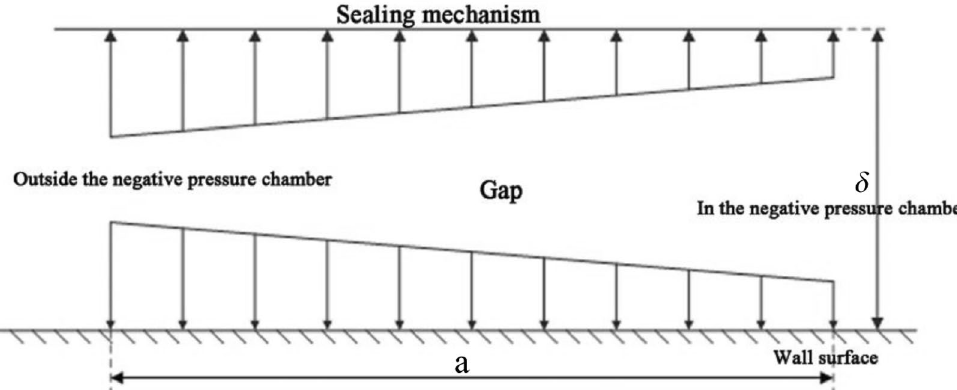
Figure 3. Pressure distribution in the gap.